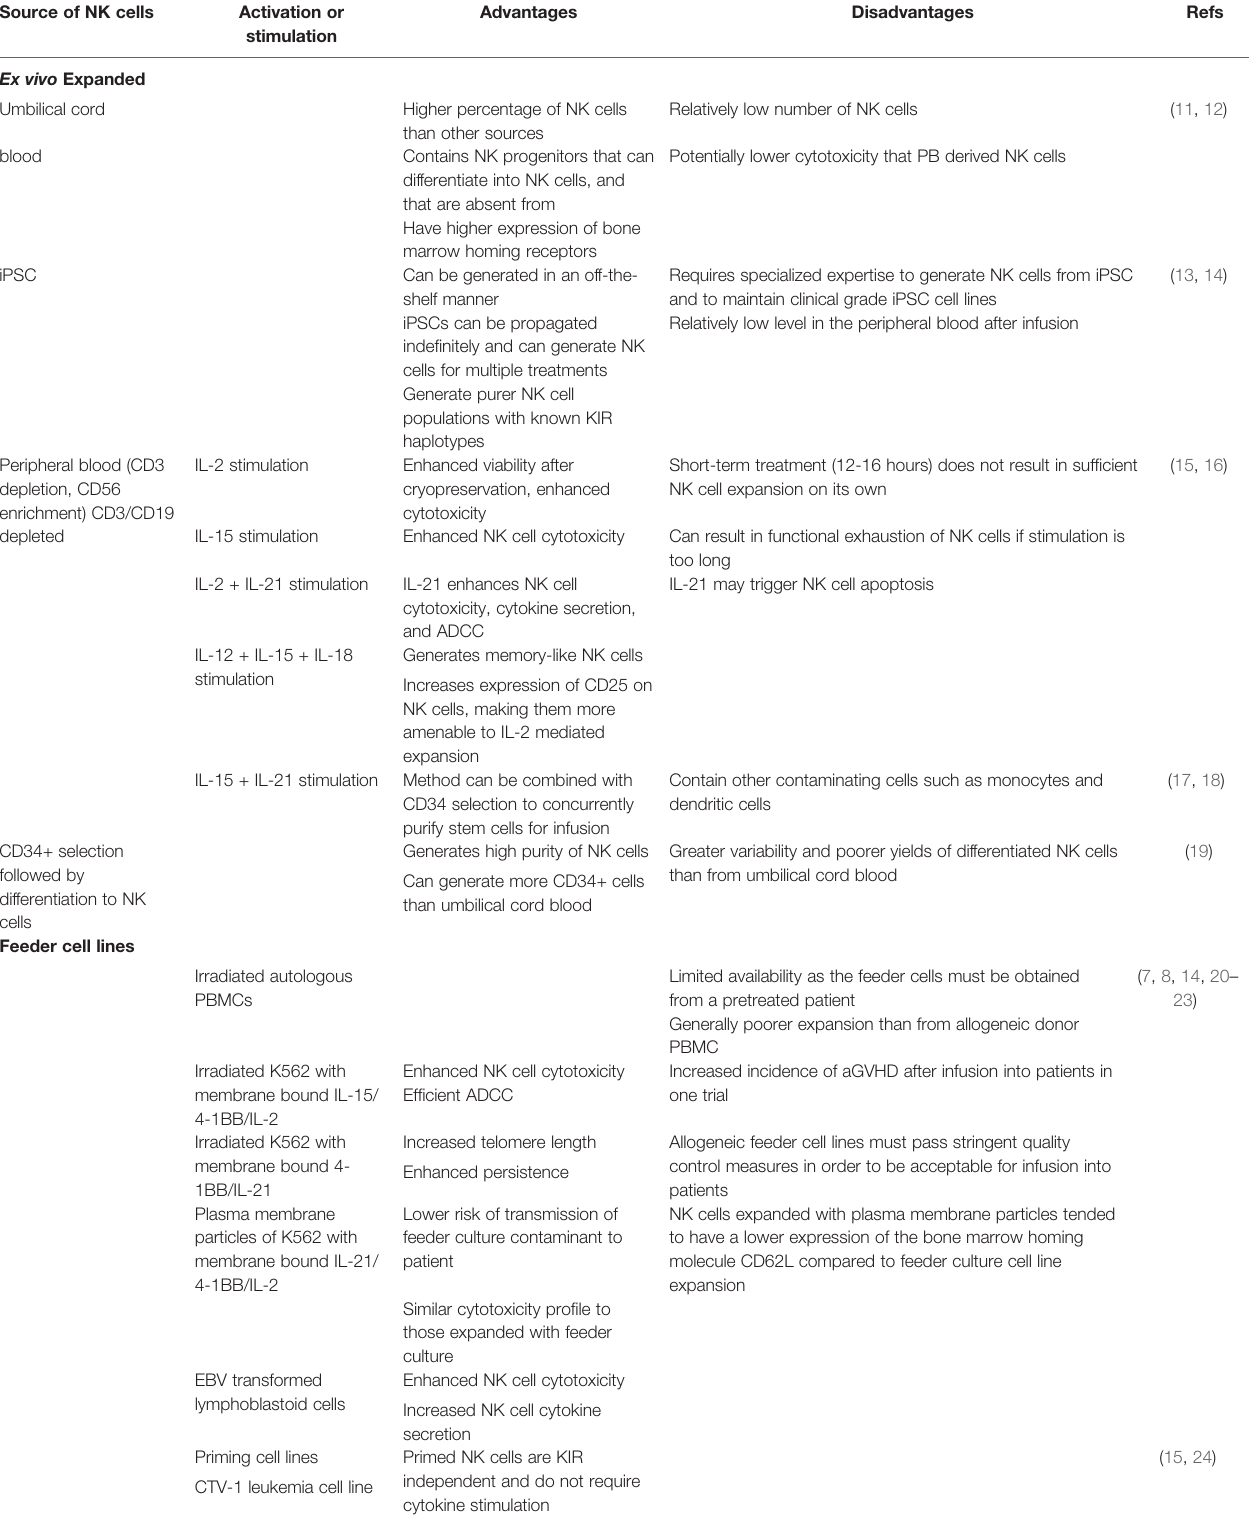
TABLE 1 | Advantages and disadvantages of different methods of NK cell expansion for adoptive transfer studies. Source of NK